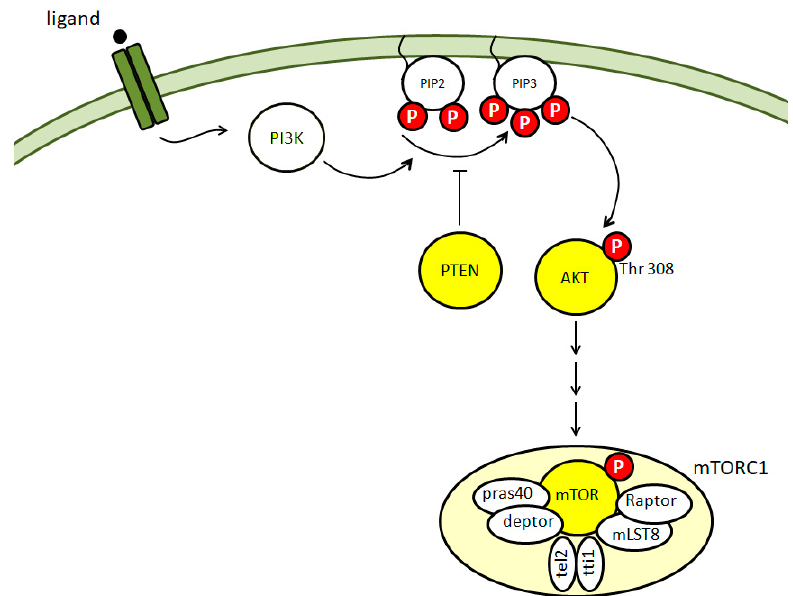
Figure 1. Schematic illustration of the mTOR signaling. The proteins investigated in the present study are highlighted in yellow. The red P indicates a phosphorylation site. mTOR, Raptor, pras40, deptor, mLST8, tel2 and tti1 form the mTORC1 complex. Abbraviations: PI3K: phosphatidylinositide 3 kinase; PIP2: phosphatidylinositol (4,5)-bisphosphate; PIP3: phosphatidylinositol (3,4,5)-trisphosphate; PTEN: phosphatase and tensin homolog; AKT: protein kinase B; mTOR: mammalian target